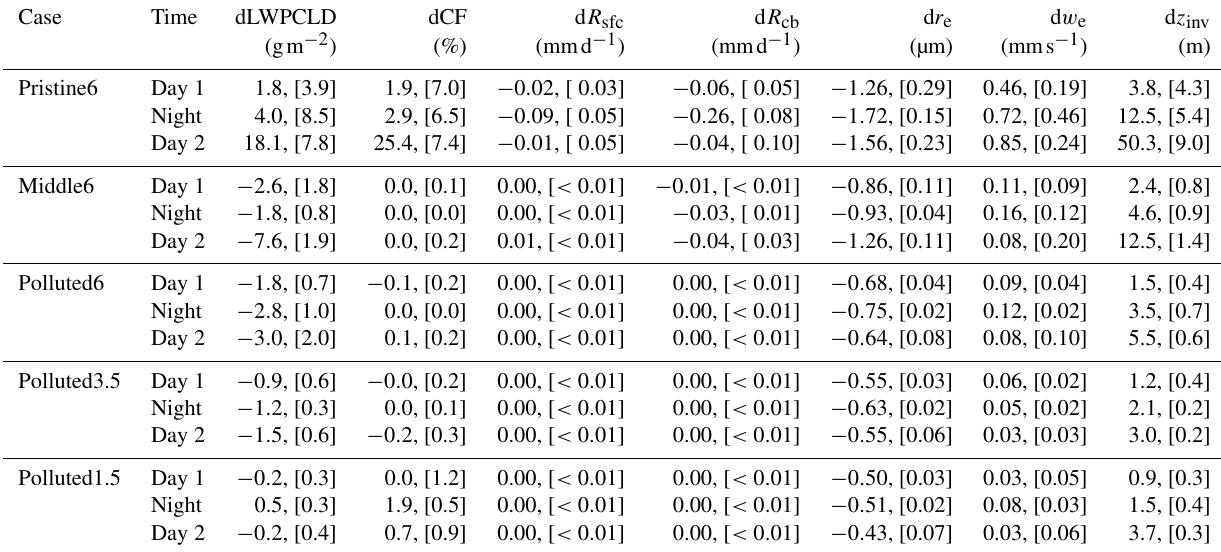
Table 3. As in Table 2 but for the differences between the Plume and Ctrl runs averaged across Day 1 (first row in each section), Night (second row in each section), and Day 2 (third row in each